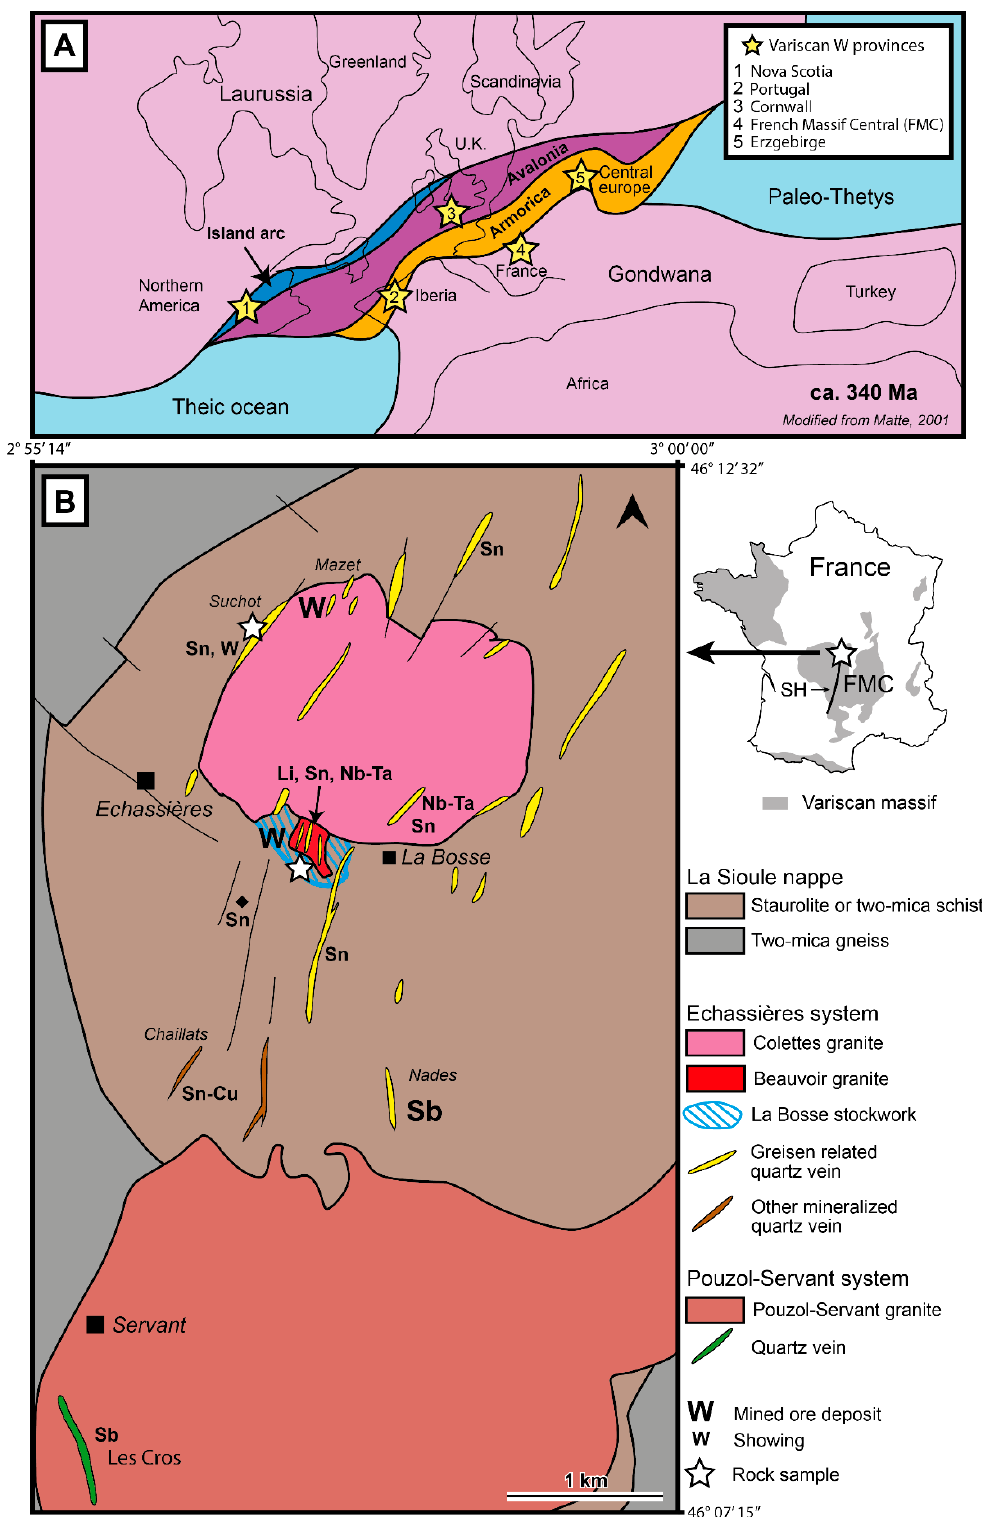
Figure 1. ( A ): Globe-scale location of the Variscan belt during collision at 340 Ma and localization of present-day main W provinces, modified after [12]. ( B ): Geological sketch ‐ map and location of the Echassières district (4 in Figure 1A), modified after [35]. FMC: French Massif Central, SH: Sillon Houiller Fault.